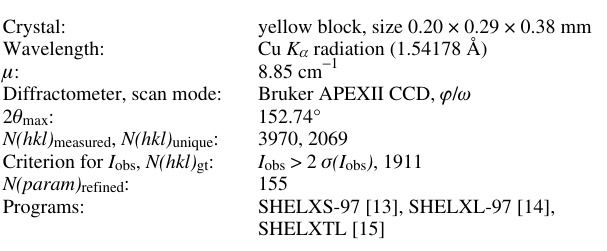
Table 1. Data collection and handling.